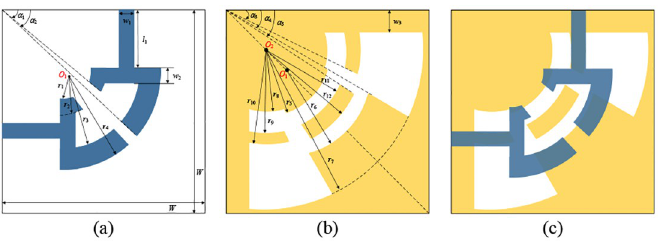
Fig 11. UWB BPF structure diagram. (a) the top layer. (b) the bottom layer. (c) UWB filter structure.